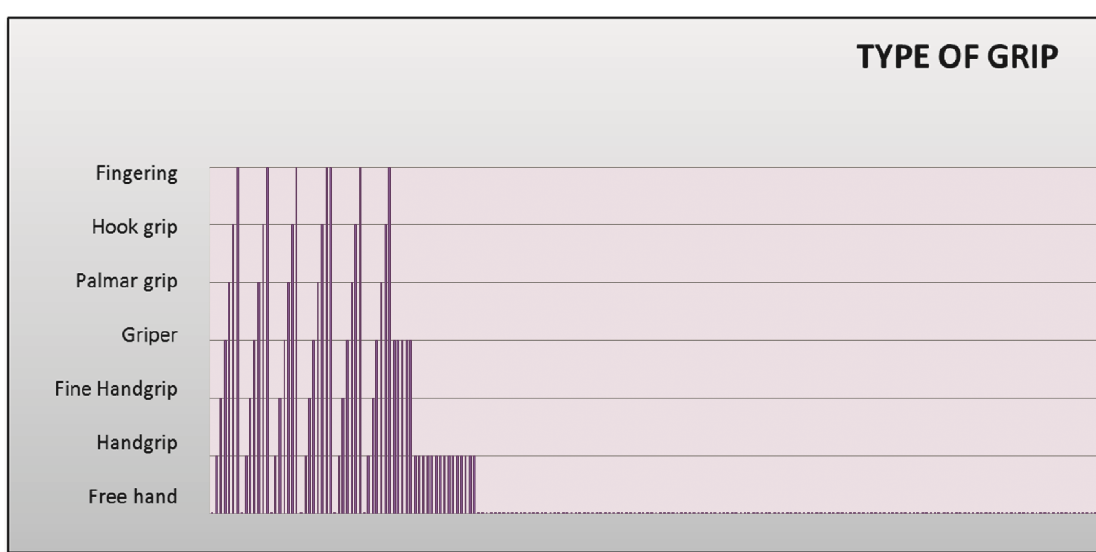
Figure 10. Data collected by the potentiometers.